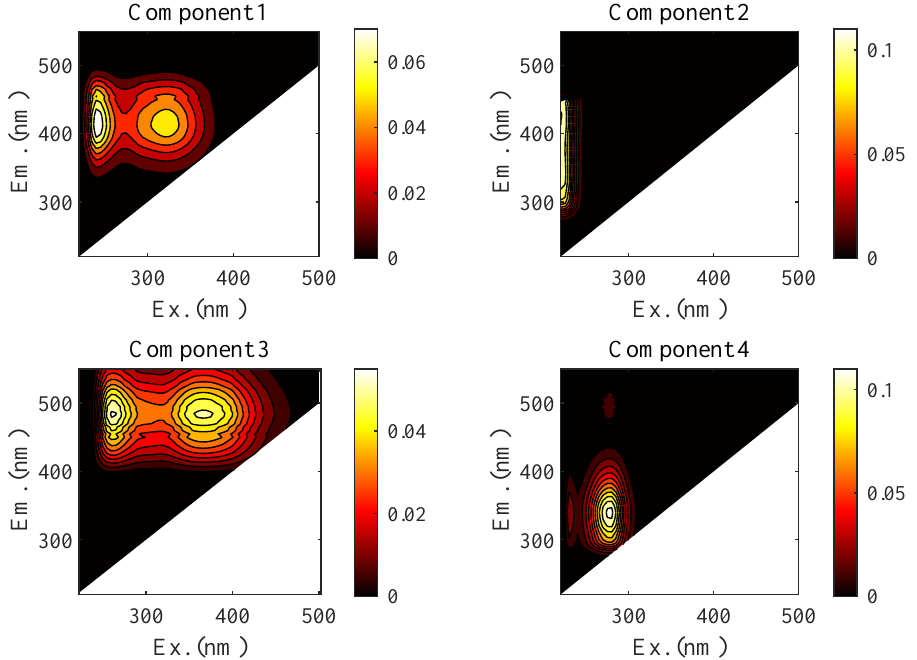
Figure 3. EEM plots of four DOM components. Component 1, component 2, component 3, and com- ponent 4 are written as C1, C2, C3, and